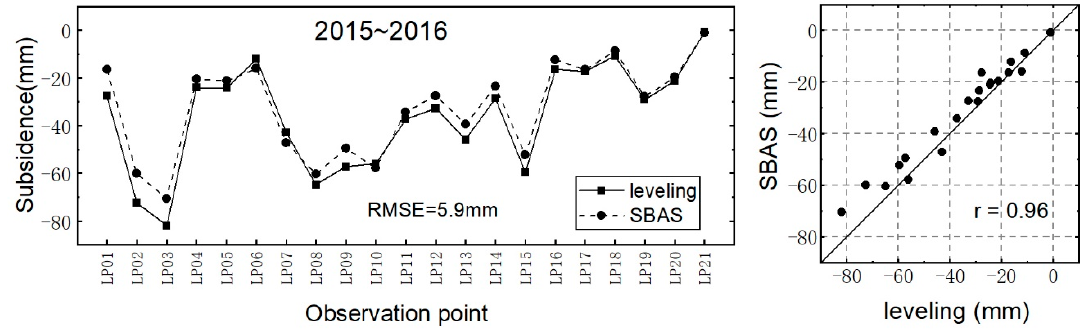
Figure 11. Comparison of SBAS and leveling results at leveling points in YNA from August 2015 to June 2016.